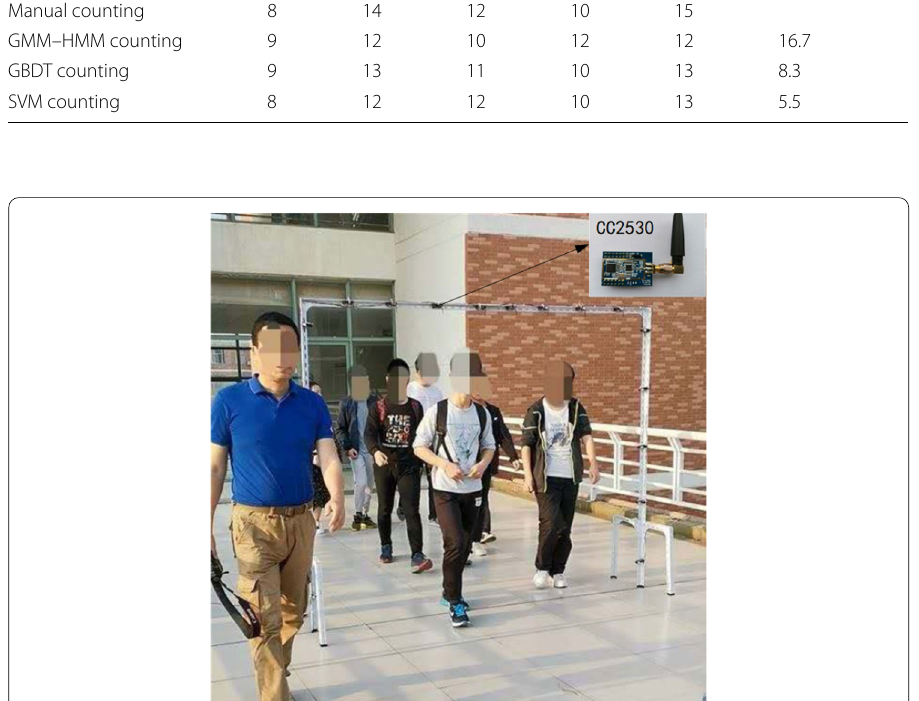
Table 3 Comparison of dynamic monitoring results with sparse personnel density Group